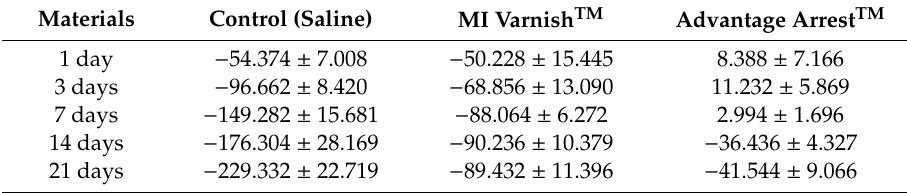
20–40 µ m after several treatment durations with the three tested